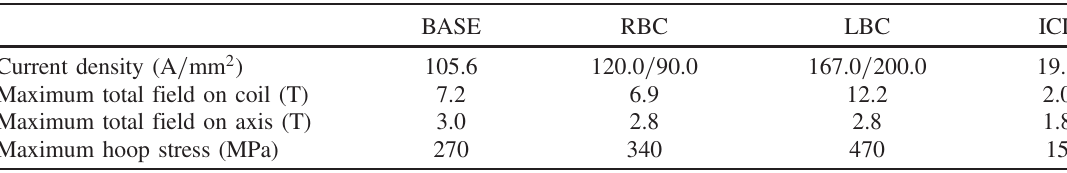
TABLE II. Lattice characteristics of each cooling